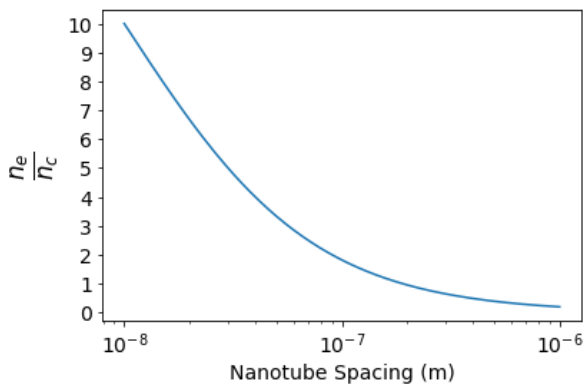
Figure 7. Ratio of perceived electron density to critical density n e / n c as a function of the vacuum spacing between CNTs. (Note that this ratio is the reciprocal of that quoted in previous sections.) The density inside a CNT is 10 22 cm − 3 , and the width of a CNT is 10 nm. The laser wavelength is 1 micron.